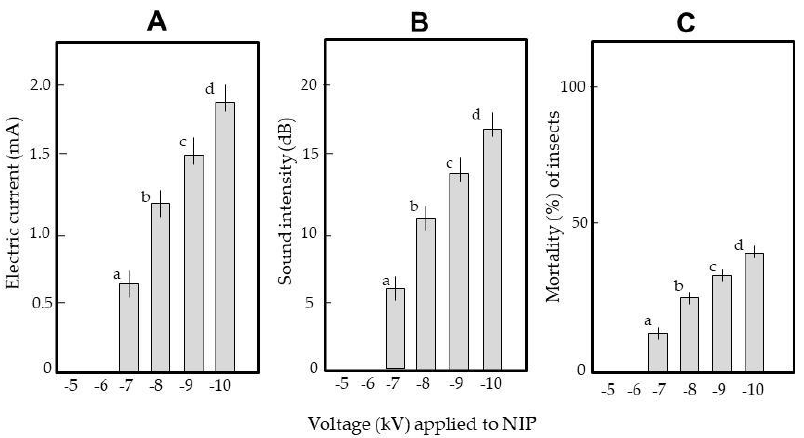
Figure 6. Generation of transient electric currents ( A ) and arcing sounds ( B ), and the mortality ( C ) of weevils arced in the electric field of the ADE. Insects were blown into the space between the NIP and GIP of an ADE negatively charged at different voltages. Twenty insects were tested at each voltage; the means and standard deviations of five replicates are shown. Letters (a–d) on a column indicate significant differences ( p < 0.05), as revealed by the Tukey method.